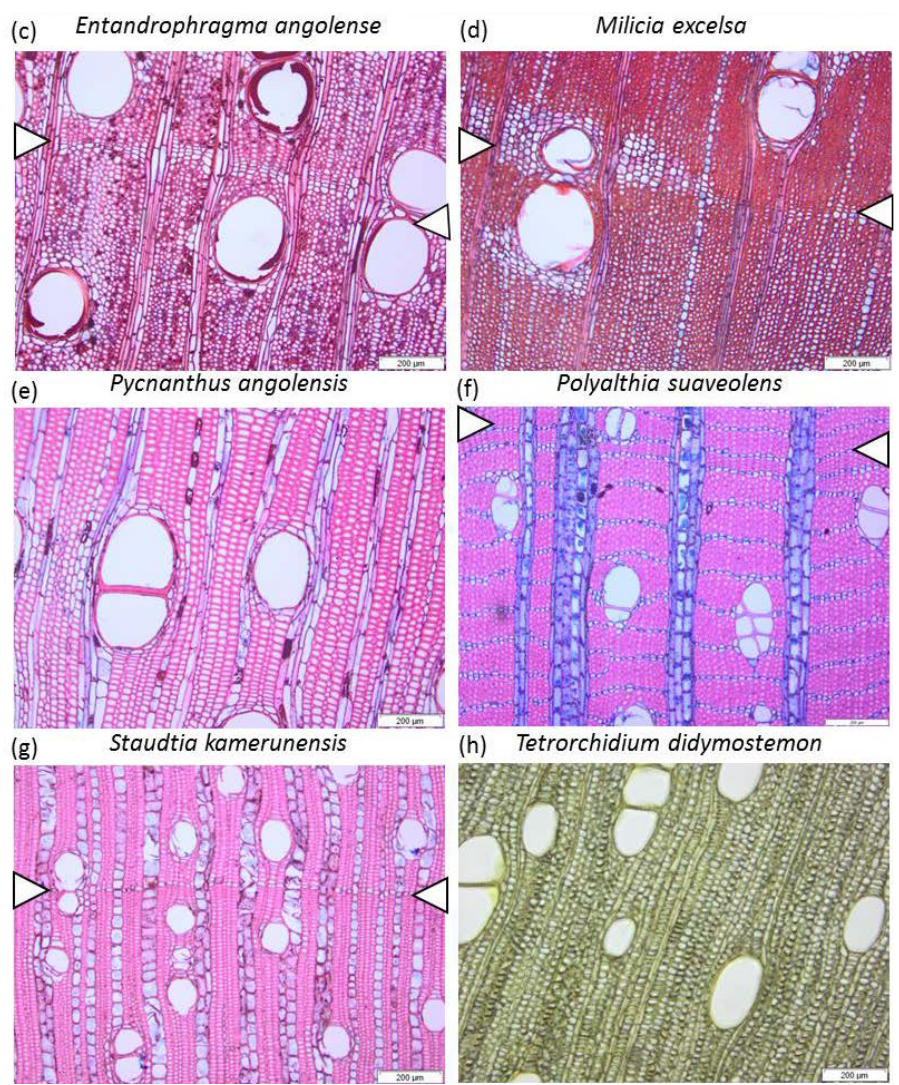
Figure 1 . Microscopic sections of Tervuren Wood references samples of the corresponding species, showing wood anatomy, and, when available, the growth ring boundaries (white triangles). The species are mostly diffuse porous, with vessels solitary or slightly grouped. ( a ) Anonidium mannii , Tw72, ( b ) Canarium schweinfurthii , Tw61151, ( c ) Entandrophragma angolense Tw1432, ( d ) Milicia escelsa Tw943, ( e ) Pycnanthus angolensis Tw1513, ( f ) Polyaltia suaveolens Engl. & Diels. Tw32618, ( g ) Staudtia